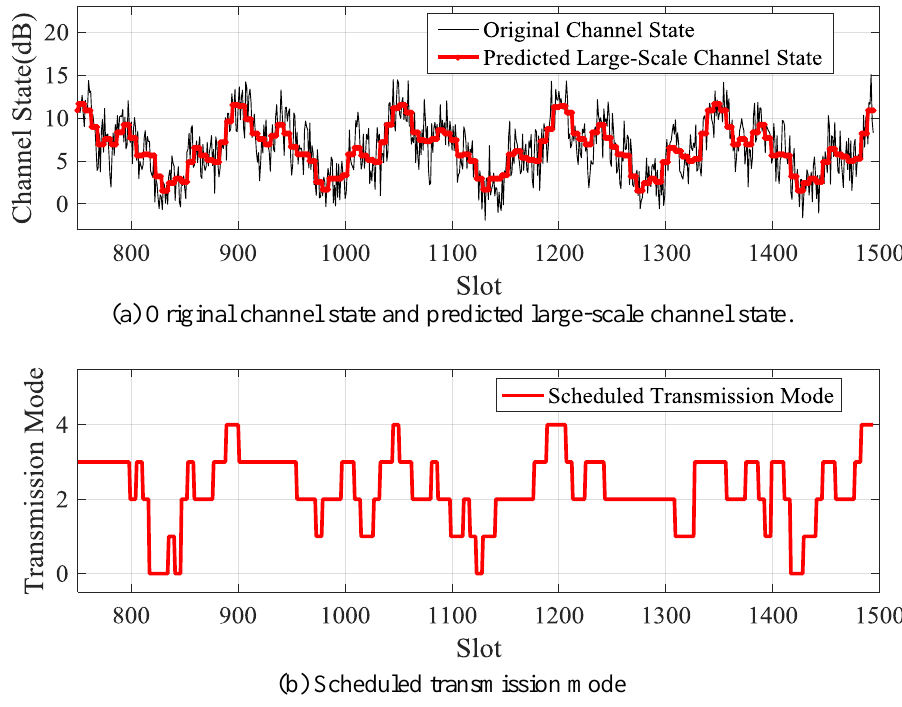
Figure 21. Scheduled transmission mode according to predicted large-scale channel state for Data